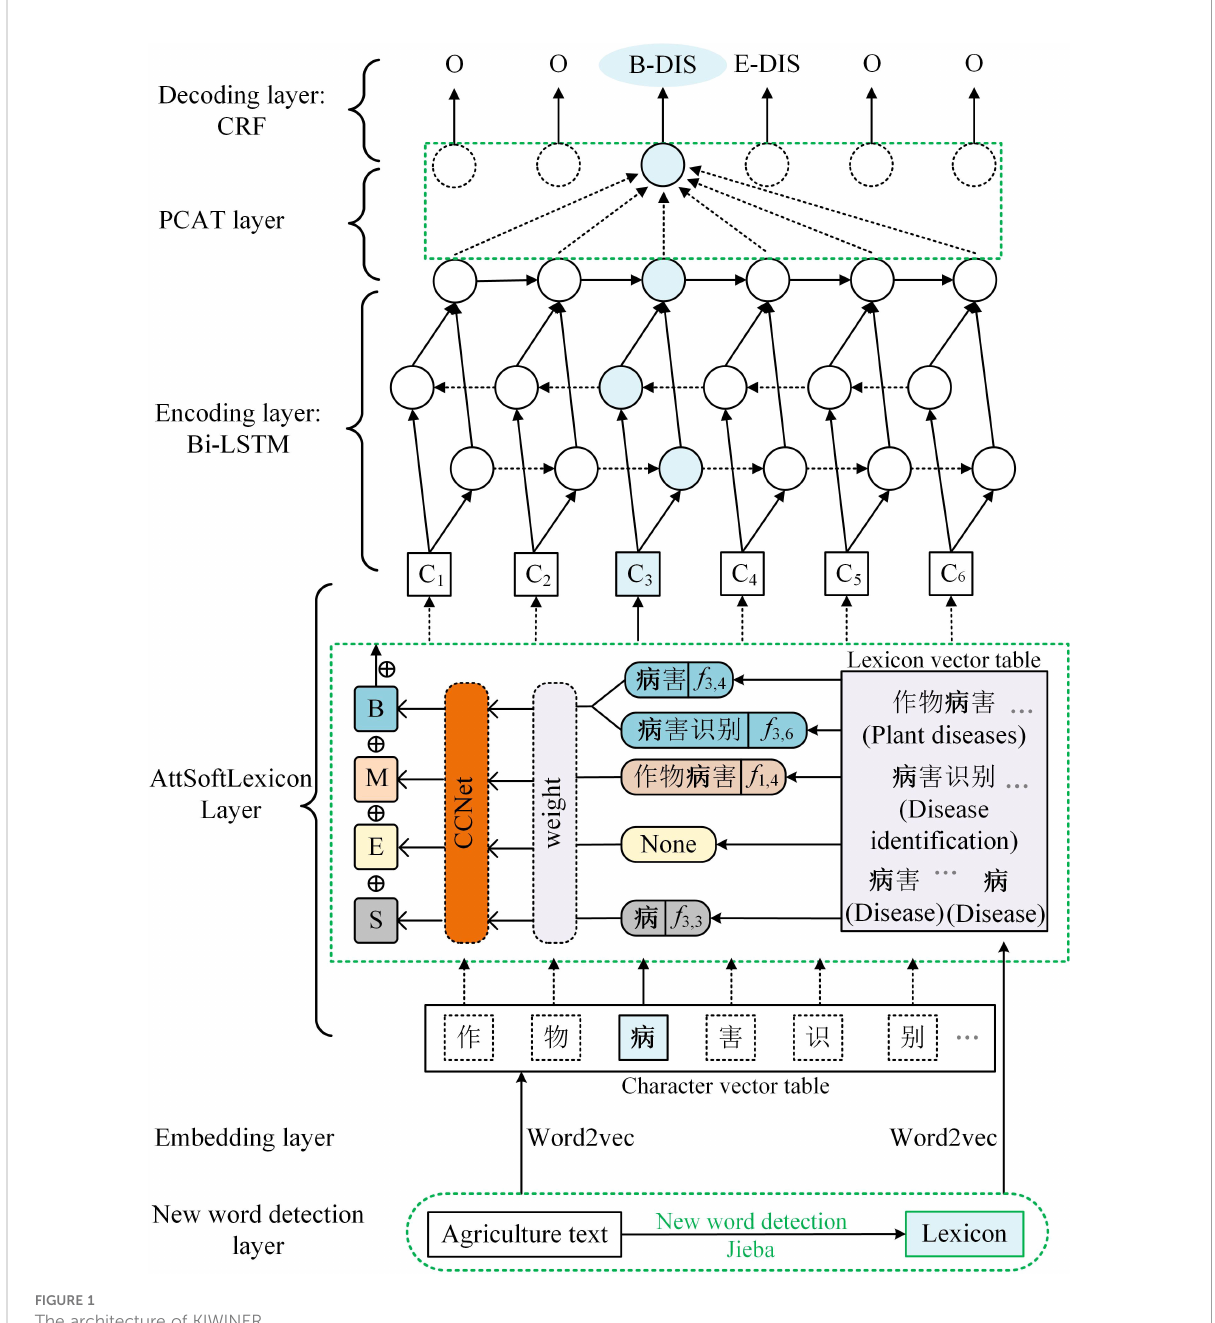
FIGURE 1 The architecture of